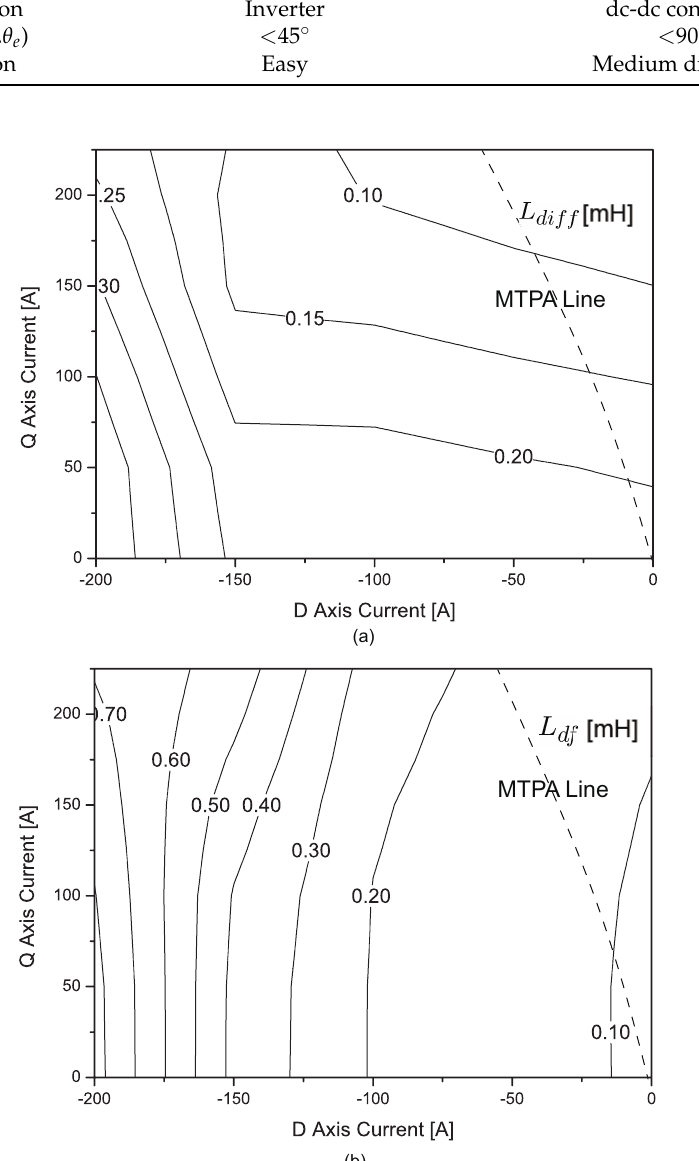
Figure 10. ( a ) L dif f , which is important for sensorless control based on signal injection into stator and ( b ) L df , which is important for sensorless control based on signal injection into